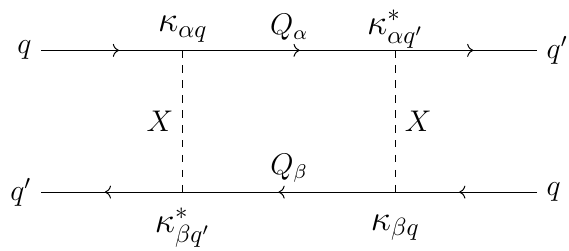
Figure 3. Parton level diagram mediating meson mixing.